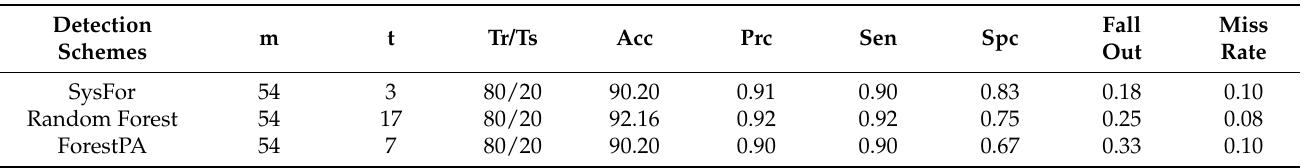
Table 8. Maximum performance received for decision forests with minimum number of decision trees on primary feature segments of Istanbul acoustic dataset.